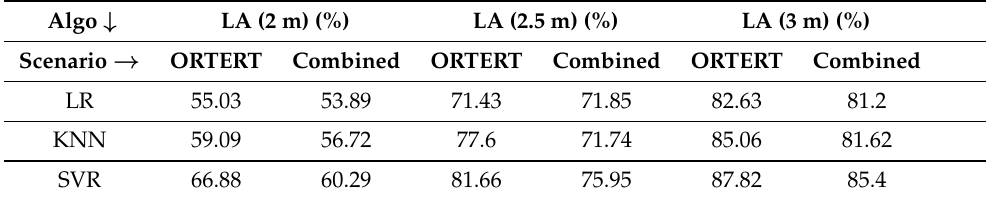
Table 12. LA analysis with different d max values for two practical scenarios.